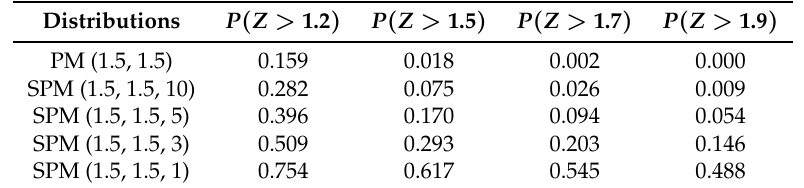
Table 1. Tails comparison for different values for parameters of the SPM and PM (1.5, 1.5) distributions. Distributions P ( Z > 1.2 ) P ( Z > 1.5 ) P ( Z > 1.7 ) P ( Z > 1.9